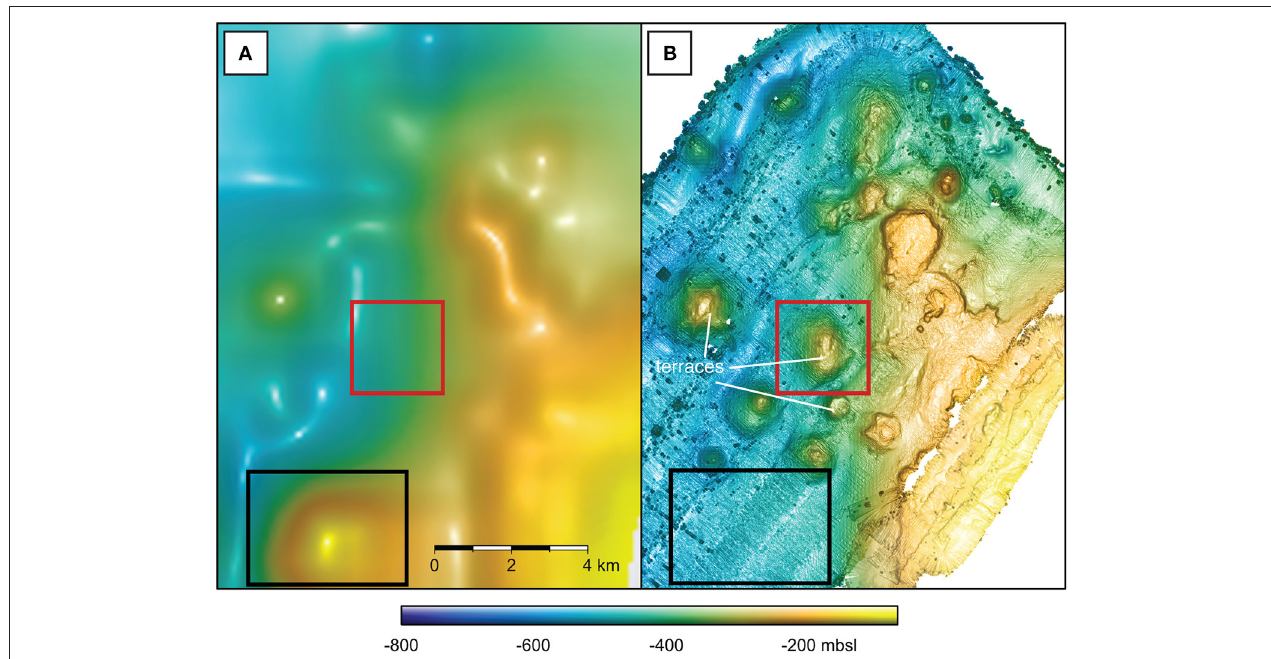
FIGURE 2 | Comparison of global bathymetry to M/V Alucia multibeam NW of Floreana, location of figure is indicated in Figure 1 . (A) Bathymetry derived from sparse sounding data and gravity anomalies calculated from satellite altimetry, gridded at ∼ 900m (Smith and Sandwell, 1997; Weatherall et al., 2015). (B) Mulitbeam bathymetry encompassing the identical area as in (A) , data are gridded at 10m. Note large anomaly in (A) (apparent seamount indicated by the black box) does not appear in (B) . Numerous smaller features not visible in the altimetry-based data appear in the multibeam data, including seamounts (indicated by the red box) and terraces are identified in the multibeam data.